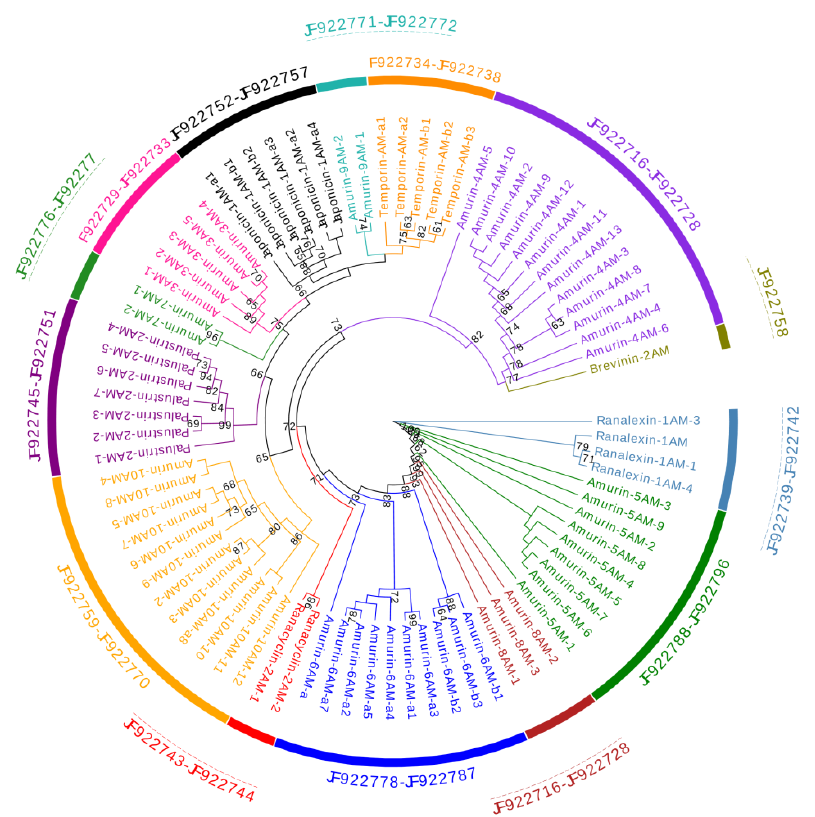
Figure 1. A phylogenetic tree of antimicrobial peptide (AMP) genes identified from R. amurensis . The